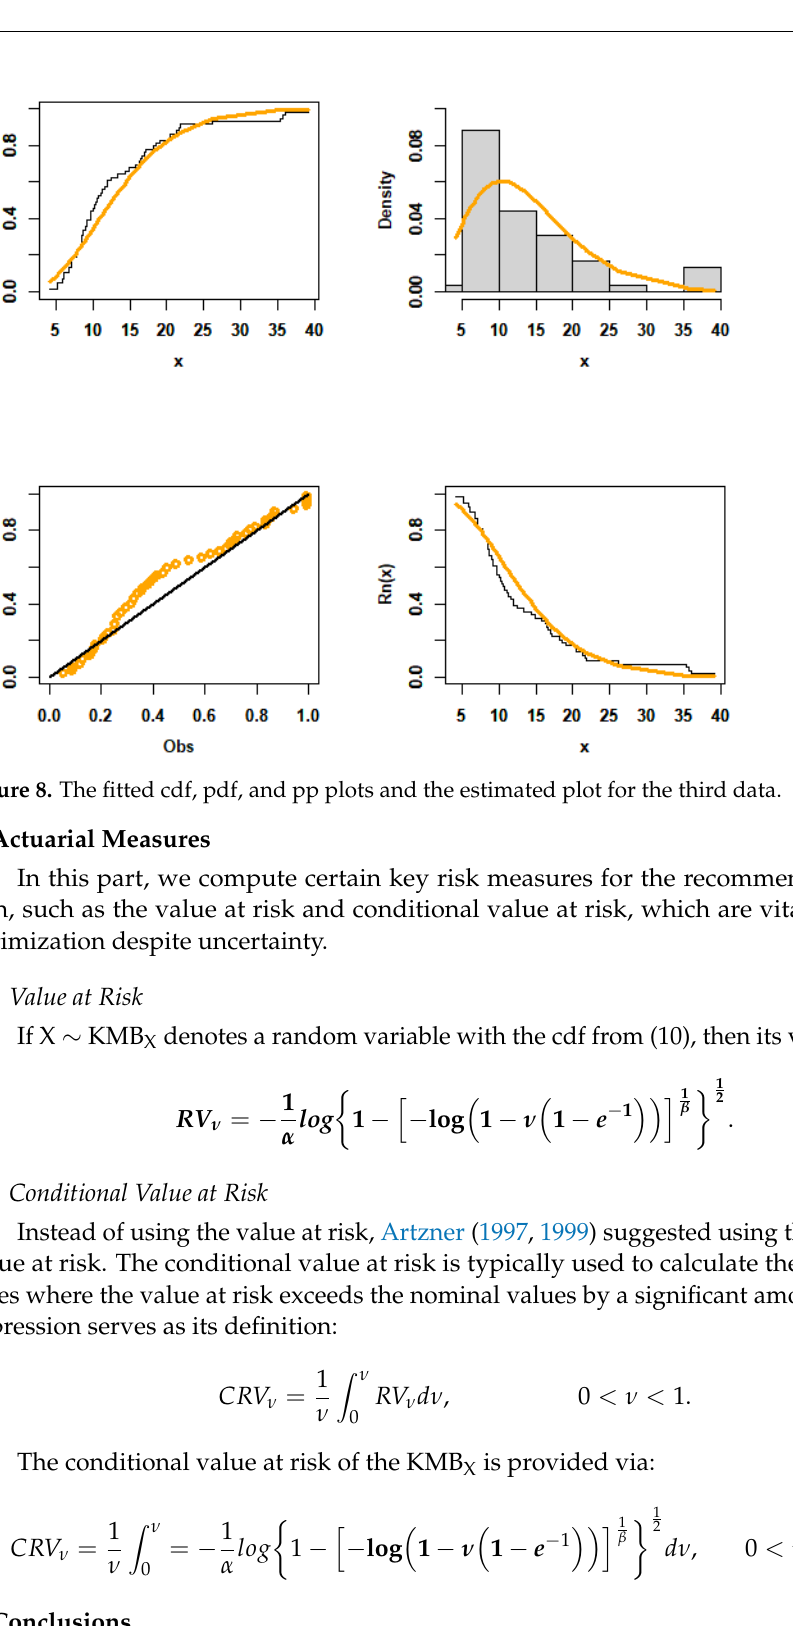
Figure 7. The fitted cdf, pdf, and pp plots and the estimated plot for the second data.